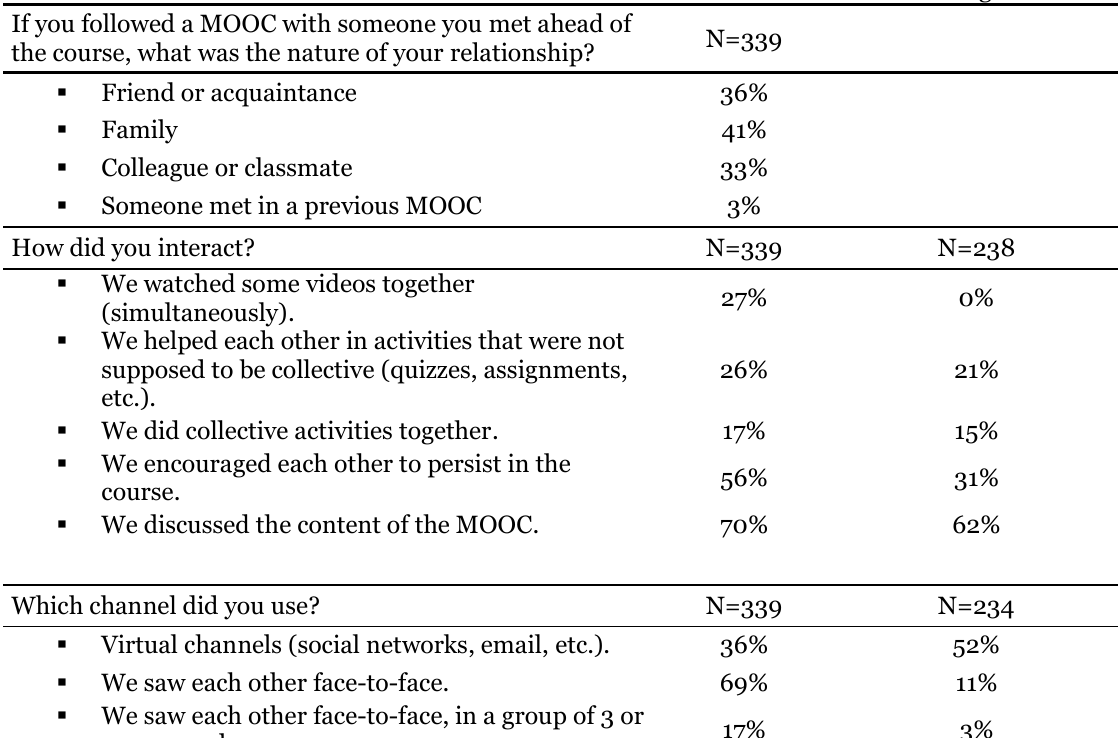
Table 3 Object and Channels Used for the Interactions Occurring Outside of the Boundaries of the Discussion Forum for MOOCs Followed Before Answering the Survey